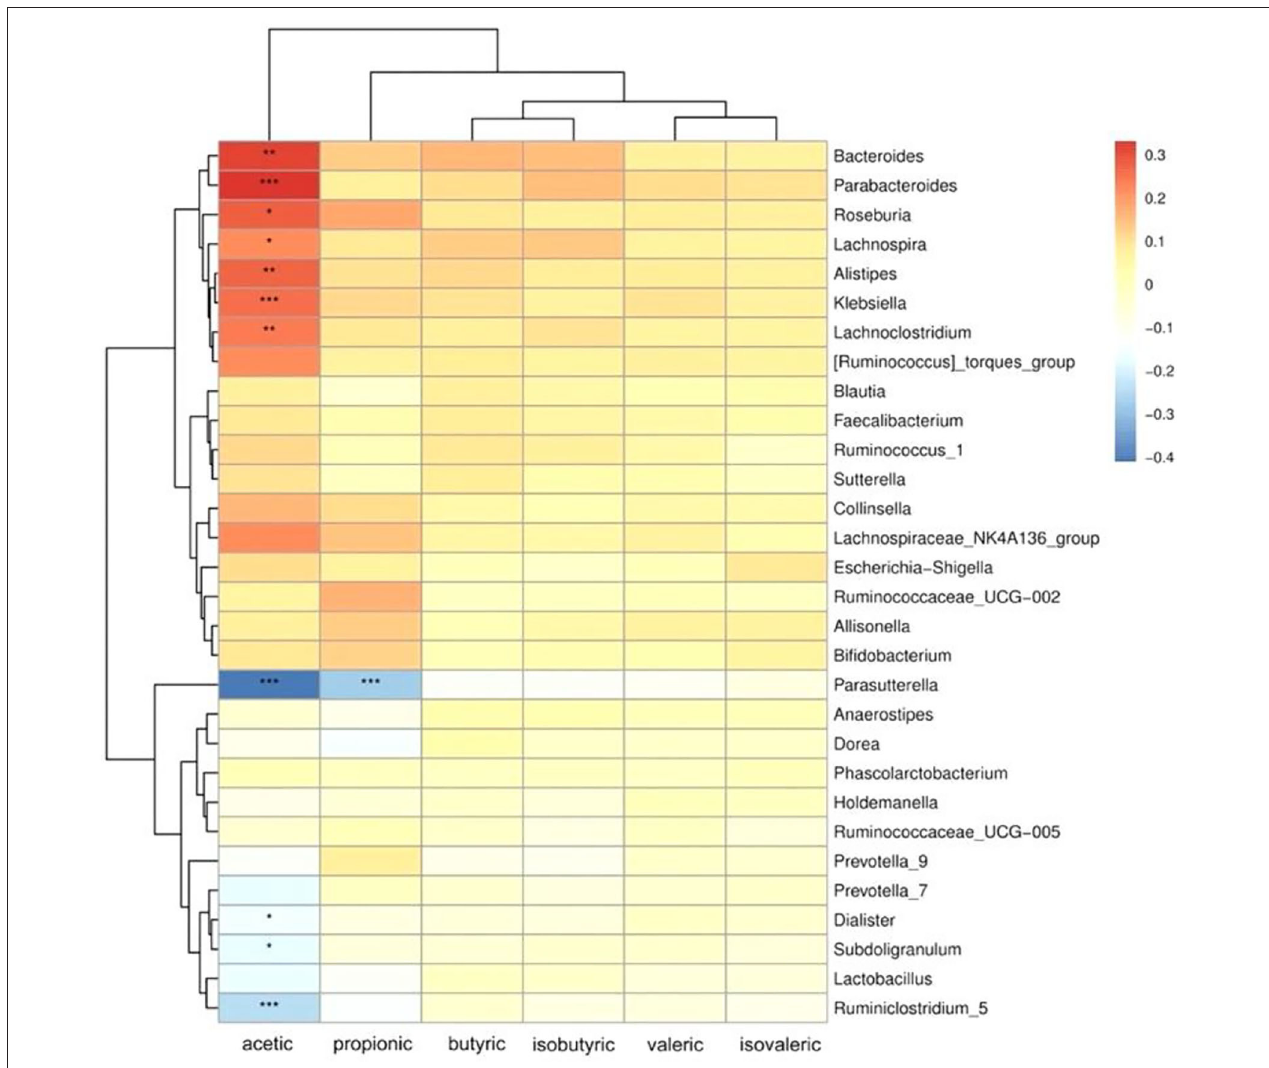
FIGURE 5 | Heatmap of Spearman’s rank correlation coefficients between SCFAs production and microbial relative abundance at the genus level. The colors indicate positive (red) or negative (blue) correlations between SCFA production and microbial relative abundance. The X -axis shows the different SCFAs, from left to right: acetic acid, propionic acid, butyric acid, isovaleric acid, isobutyric acid, and valeric acid. The Y -axis shows different genera. * P < 0.05, ** P < 0.01, *** P <